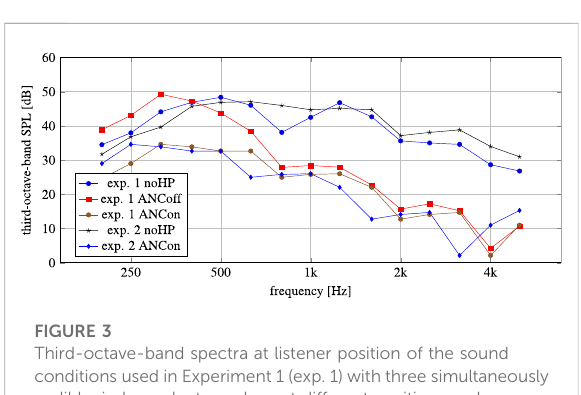
FIGURE 3 Third-octave-band spectra at listener position of the sound conditions used in Experiment 1 (exp. 1) with three simultaneously audible, independent speakers at different positions and Experiment 2 (exp. 2) with one audible speaker. Conditions without headphones (noHP), with ANC headphones switched off (ANCoff) and ANC headphones switched on